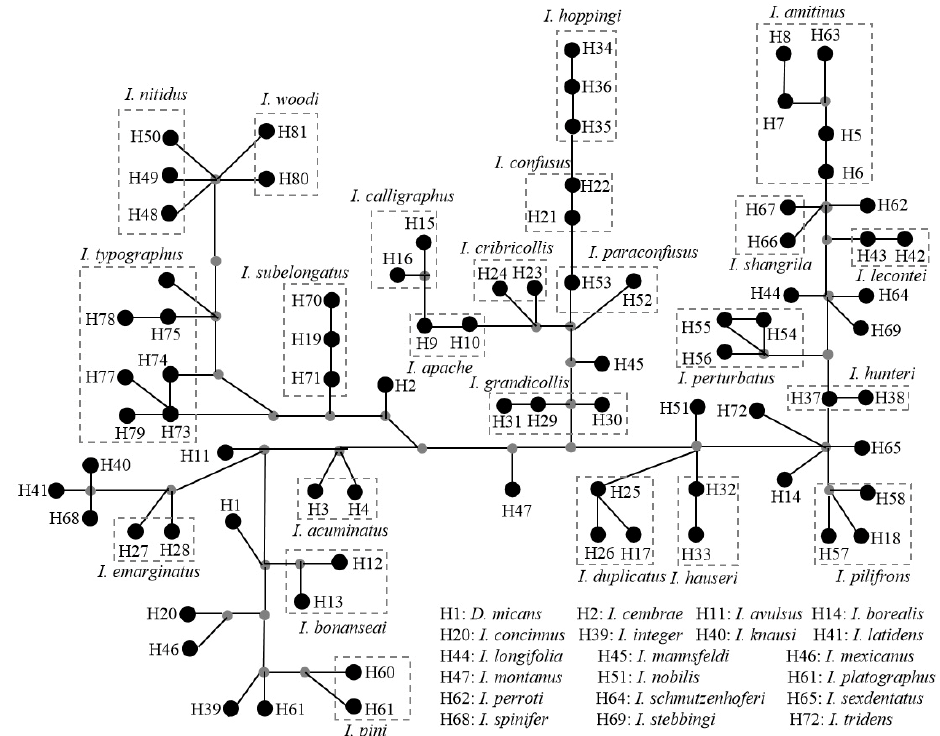
Figure 3. Median-joining network based on the COI gene. Each circle represents a haplotype, different areas in the dashed line correspond to different species. The gray dots represent the mutation nodes.